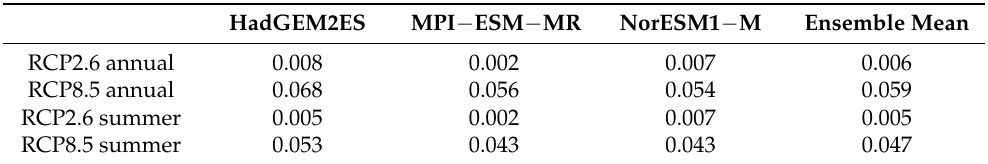
Table 1. Modeled annual and summer mean temperature warming rate ( ◦ C · a − 1 ) at the elevation of AWS projected by RegCM4 driven by 3 ESMs under RCP2.6 and RCP8.5 from 2018 to 2098. HadGEM2ES MPI − ESM − MR NorESM1 −